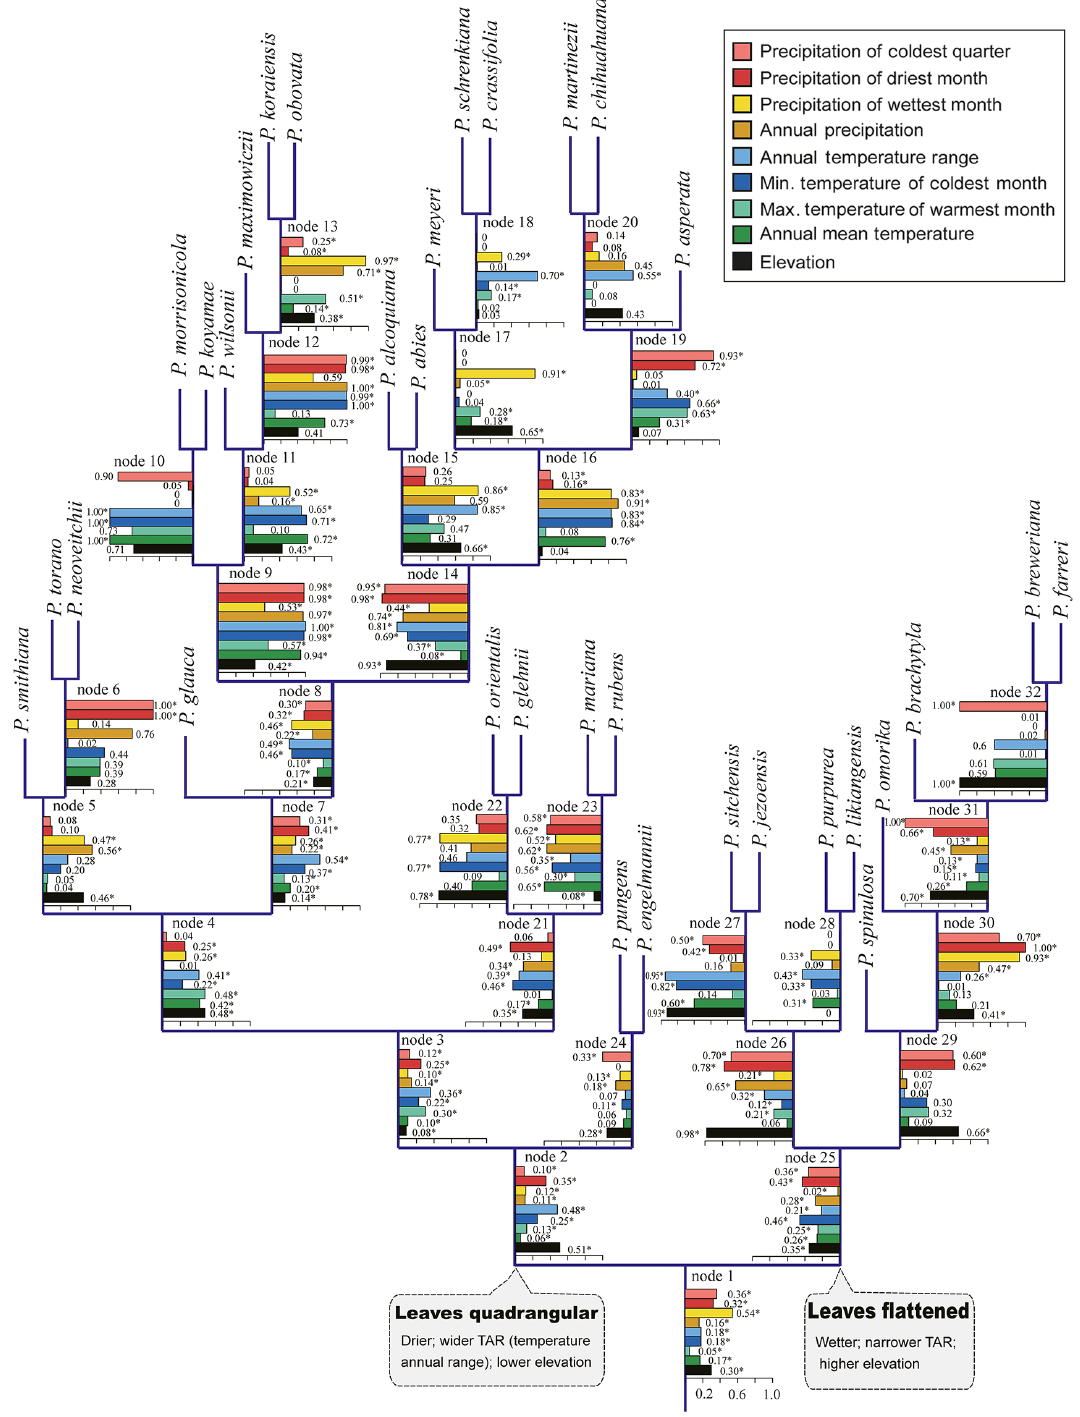
Figure 3. Divergence indices (scales range from 0 to 1) shown as histograms for elevation and for the eight climatic variables for each node of the morphology of Picea worldwide. ∗ Indicates a significant difference in ecological features after Bonferroni correction ( P < 0 .